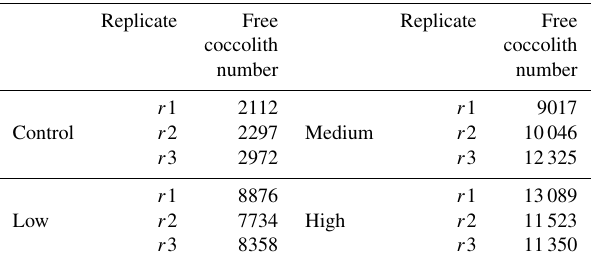
Table 4. Free C. pelagicus coccolith concentration measured with the Beckman Coulter Multisizer; r =